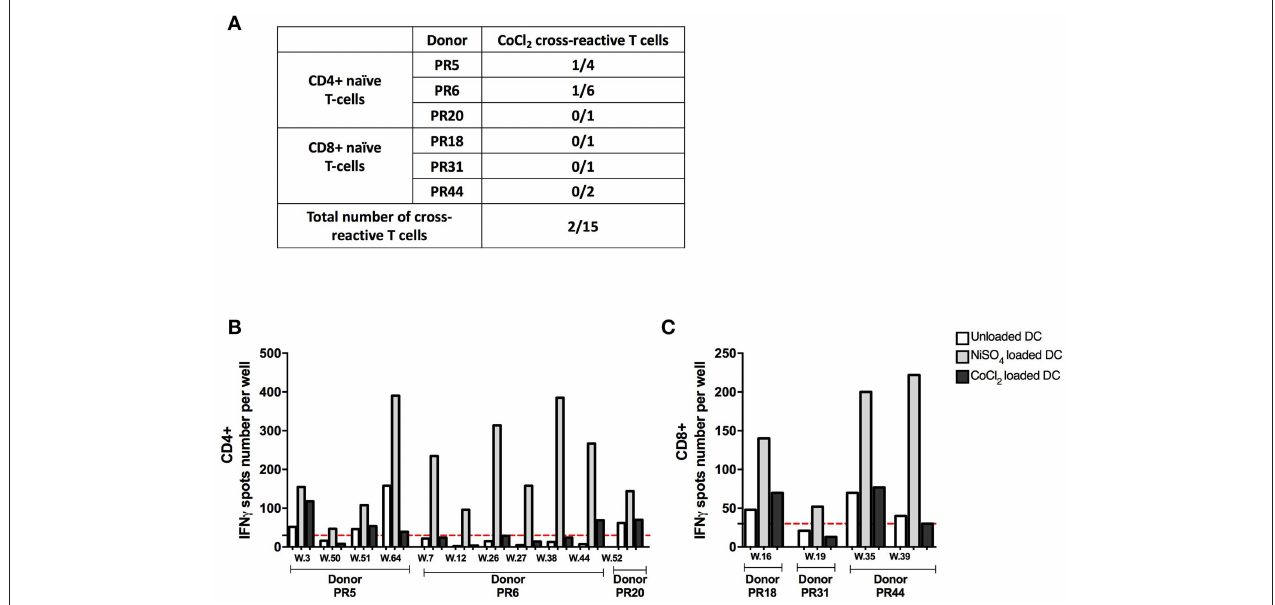
FIGURE 5 | Cobalt cross-reactivity of nickel-recognizing naïve CD4 + and CD8 + T cells. (A) Number of cross-reactive T-cell lines among nickel-specific T cells from different donors. (B) Spots count for naïve CD4 + T cells specific to nickel from donors PR5, PR6, and PR20 stimulated with unloaded DC or DC loaded with NiSO 4 or DC loaded with CoCl 2 . (C) Spots count for naïve CD8 + T cells specific to nickel from donors PR18, PR31, and PR44 stimulated with unloaded DC or DC loaded with NiSO 4 or DC loaded with CoCl 2. Dashed line represents the minimum required spots count (count = 30) for the analysis be considered acceptable. w,